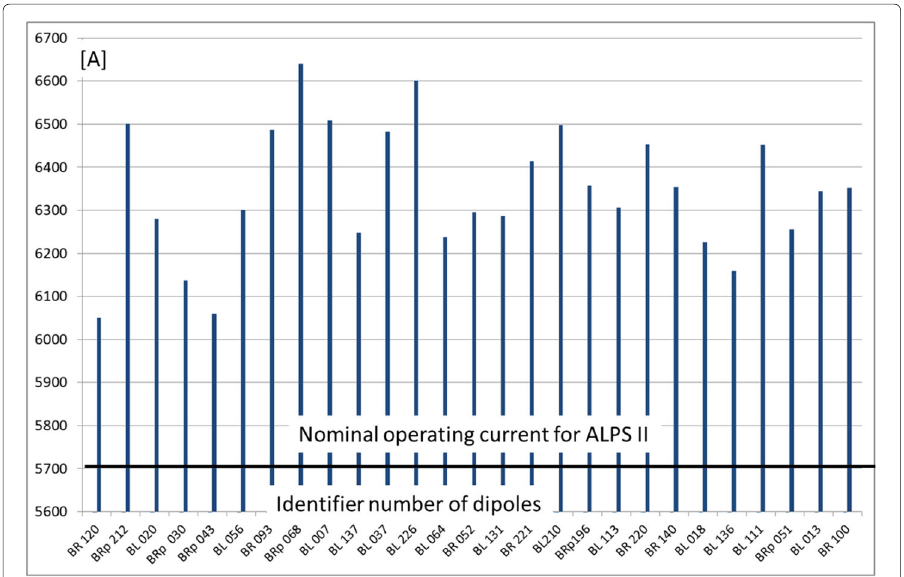
Fig. 22 Measured quench currents of straightened dipoles at the test bench versus the identification number of the dipoles according to the chronicle order of the